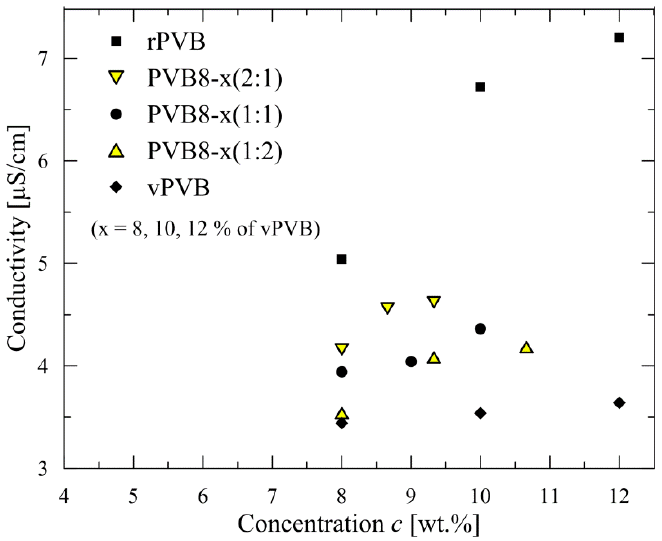
Figure 3. Conductivity of recycled, blended, and virgin PVB.